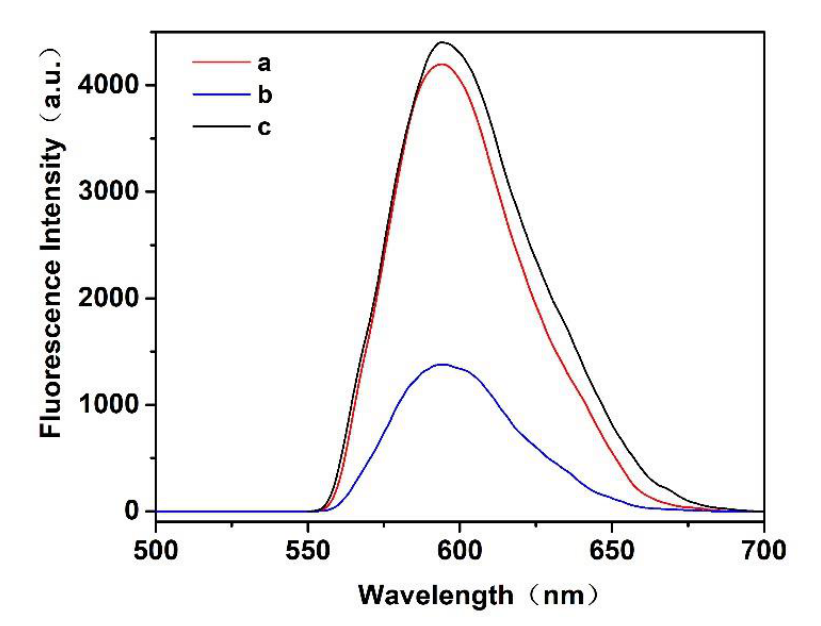
Figure 2. Fluorescence spectra of a MIP@QDs, b MIP@QDs rebinding of SAM, and c NIP@QDs. The morphology and size distribution of the prepared Mn 2+ : ZnS QDs and MIP@QDs